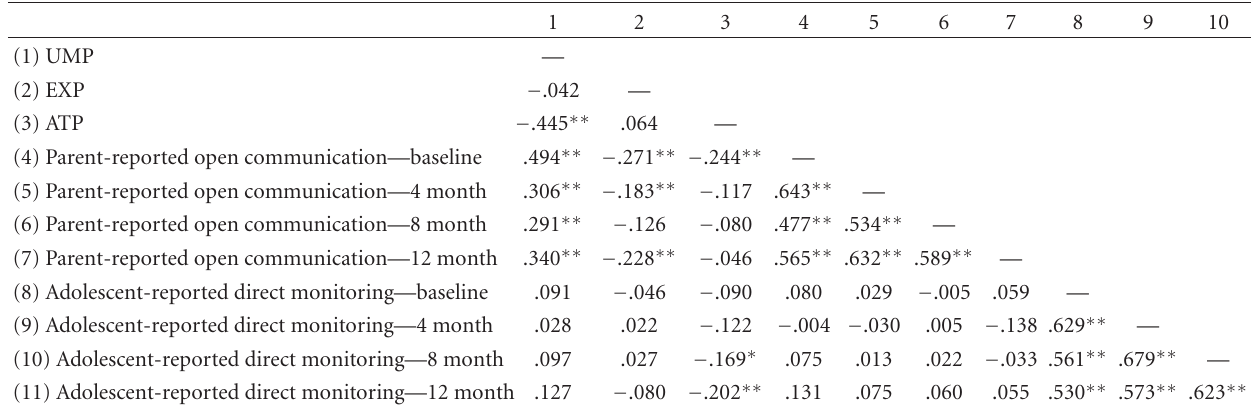
Table 2: Pearson correlations among study variables (intervention participants, N =